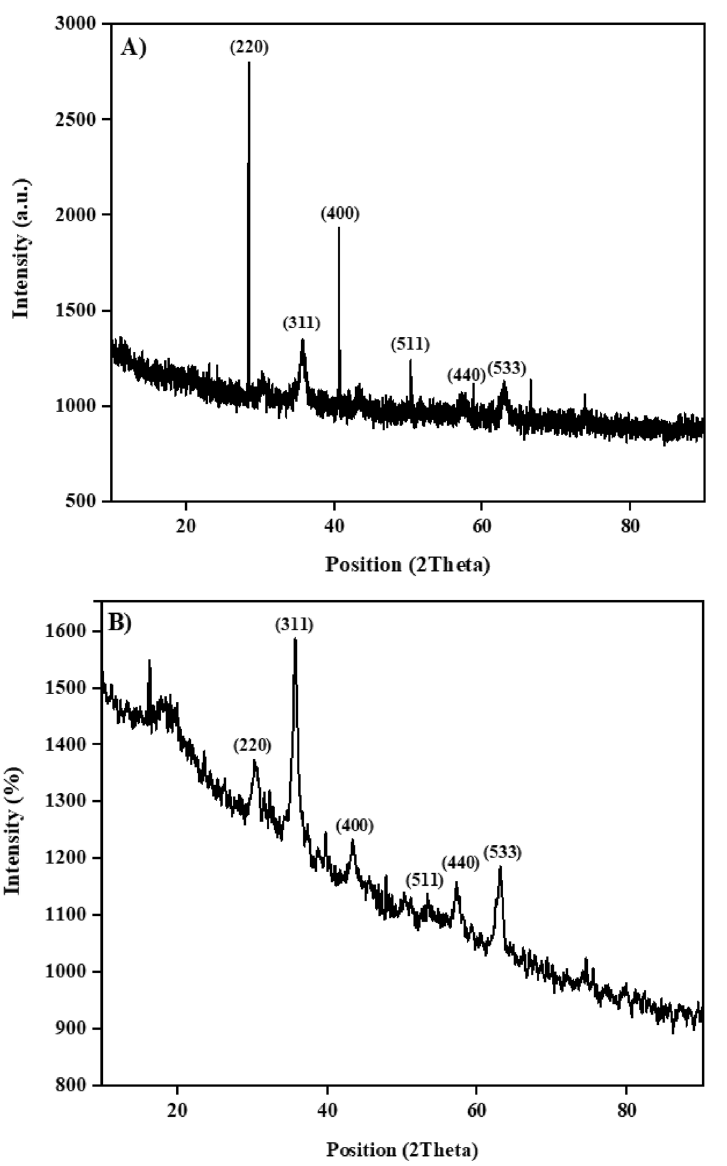
Figure 1. XRD powder pattern of Ps@Tet@Fe 3 O 4 ( A ) and Ps@Tet-Cu(II)@Fe 3 O 4 ( B